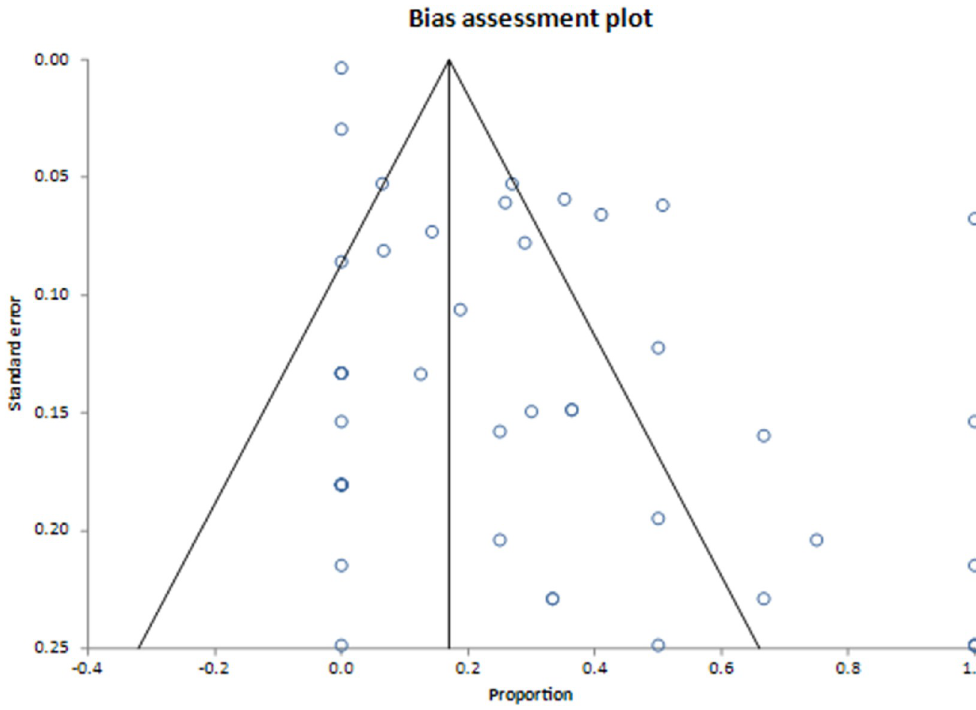
Fig 4. Bias assessment of meta-analysis of pooled proportion of infants with cCD who experience mortality a . a Publication bias is considered present when there is asymmetry of the funnel plot.